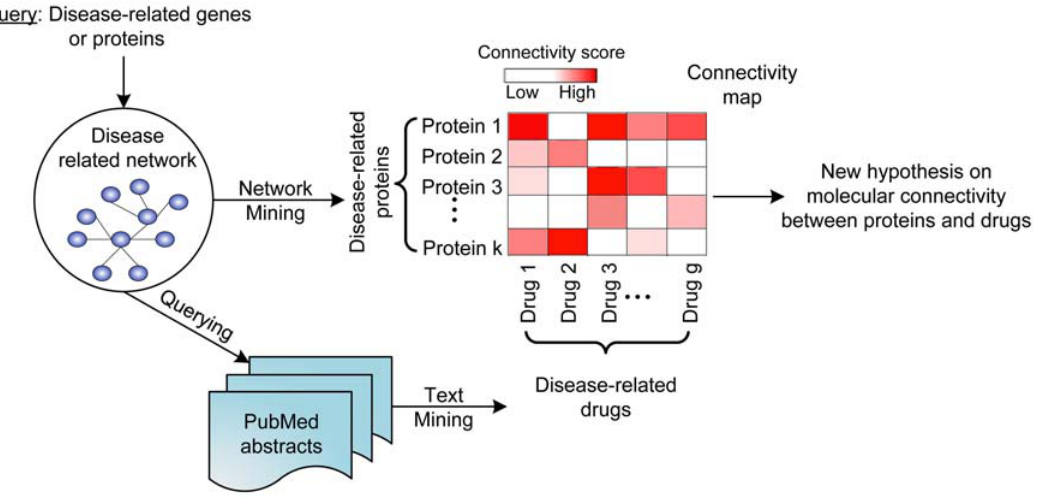
Figure 1. A conceptual paradigm for the development of disease-specific molecular connectivity maps. In this paradigm, molecular interaction data and PubMed abstracts are the primary data sources. Network mining is used to generate disease-related proteins from molecular interactions. Text mining is used to extract disease-related drug terms from PubMed abstracts and to further build drug-protein connectivity map in the disease context.